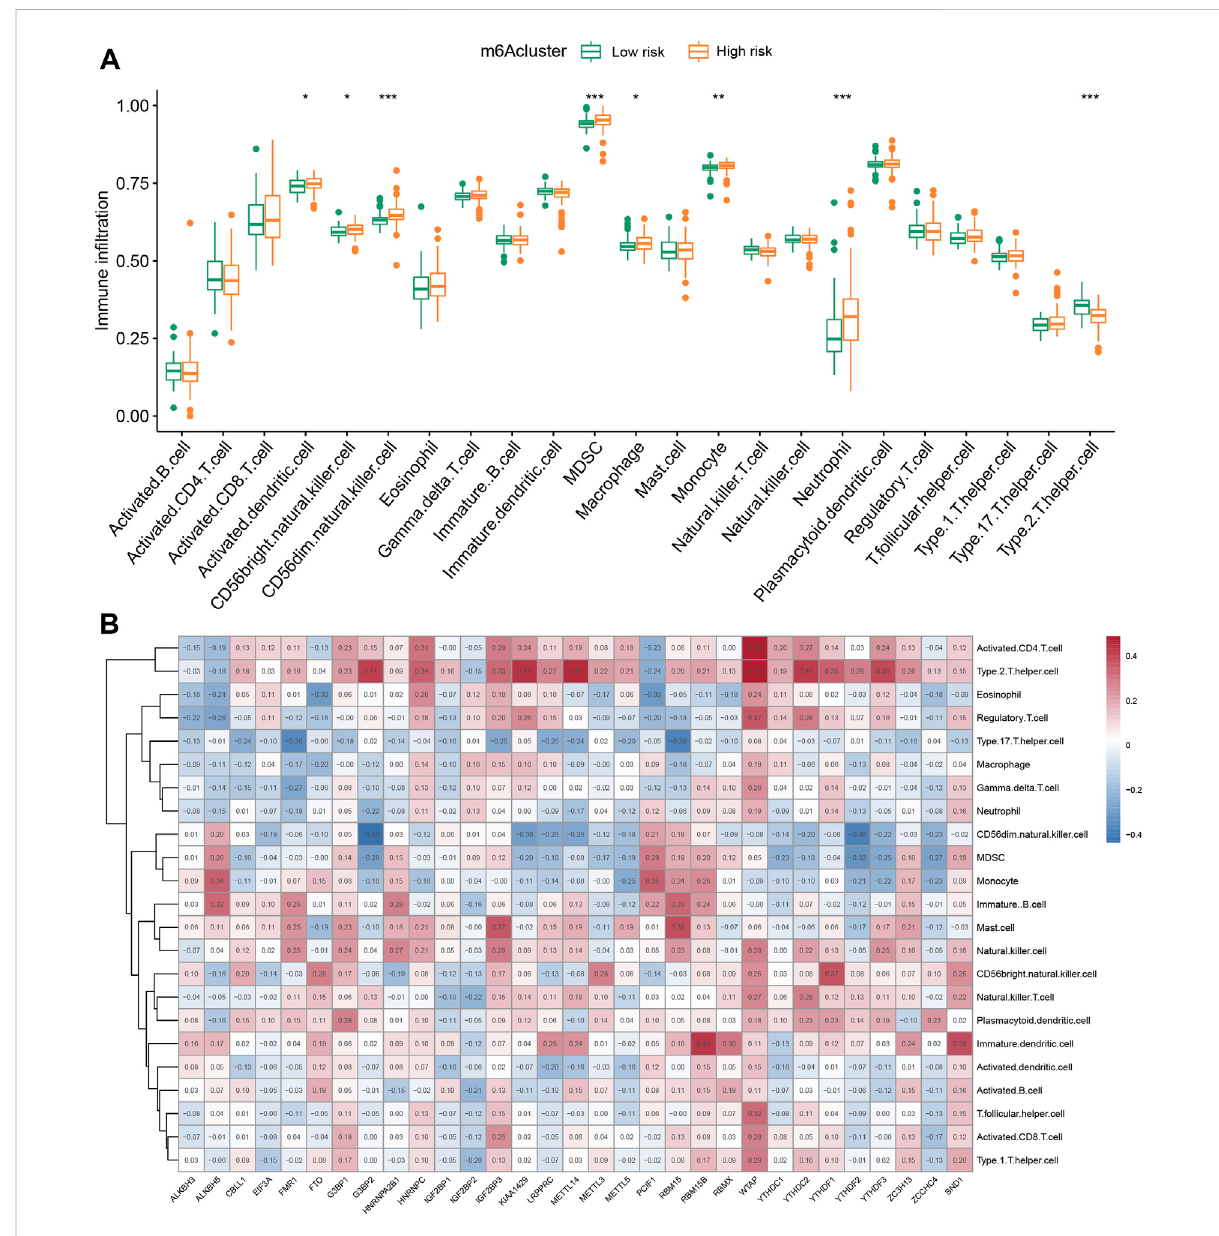
FIGURE 6 Single-sample gene set enrichment analysis. (A) Twenty-three immune cell in fi ltration differences among various m6A risks (* p < 0.05, ** p < 0.01, *** p < 0.001). (B) Correlations between in fi ltrating immune cells and 31 m6A